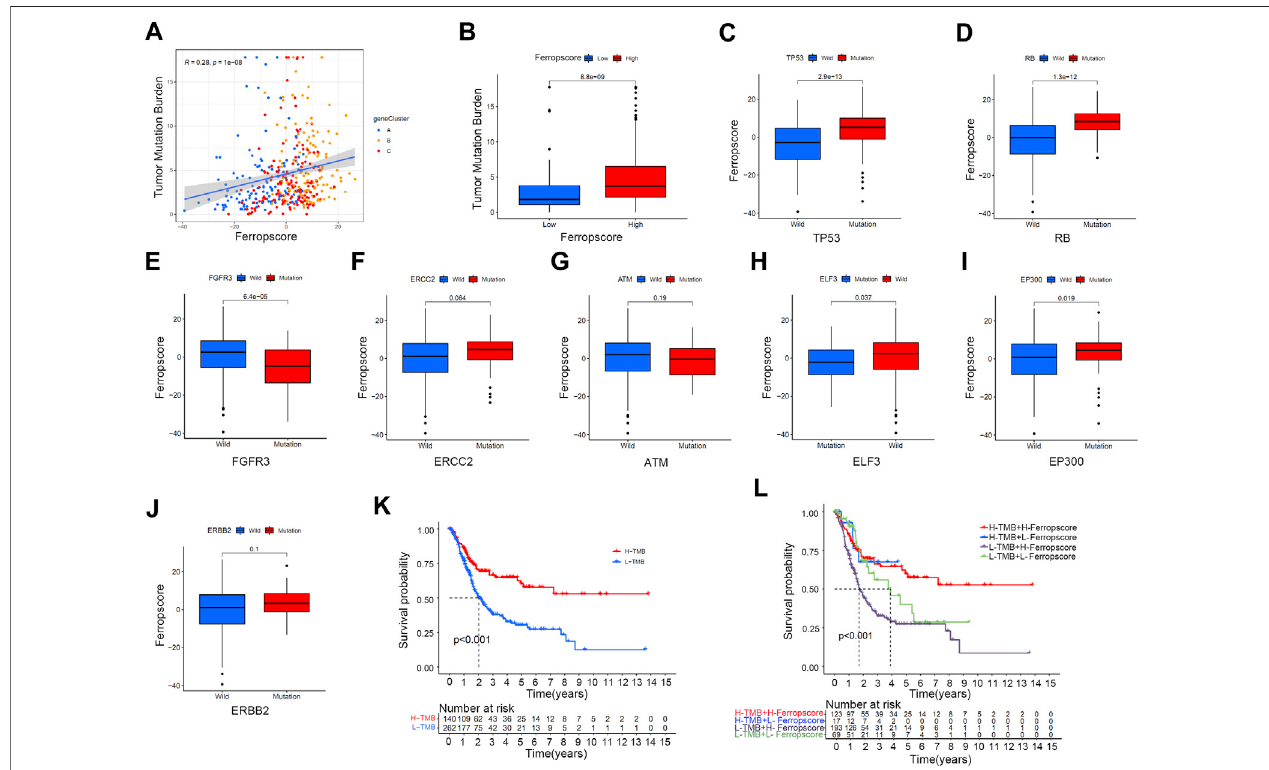
FIGURE 6 | Relationship between ferropscore and tumour genetic mutations. (A) Positive correlation between ferropscore and TMB in bladder cancer. (B) Differences in the TMB value between the high/low ferropscore groups. (C – J) Differences in ferropscores between the wild and mutation status of typical oncogenes includingTP53,RB,FGFR3,ERCC2,ATM,ELF3,EP300andERBB2. (K) Kaplan – Meiercurveanalysisshowingprognosisbene fi tsofhighTMB. (L) Kaplan – Meiercurve analysis concerning the combination of ferropscore and